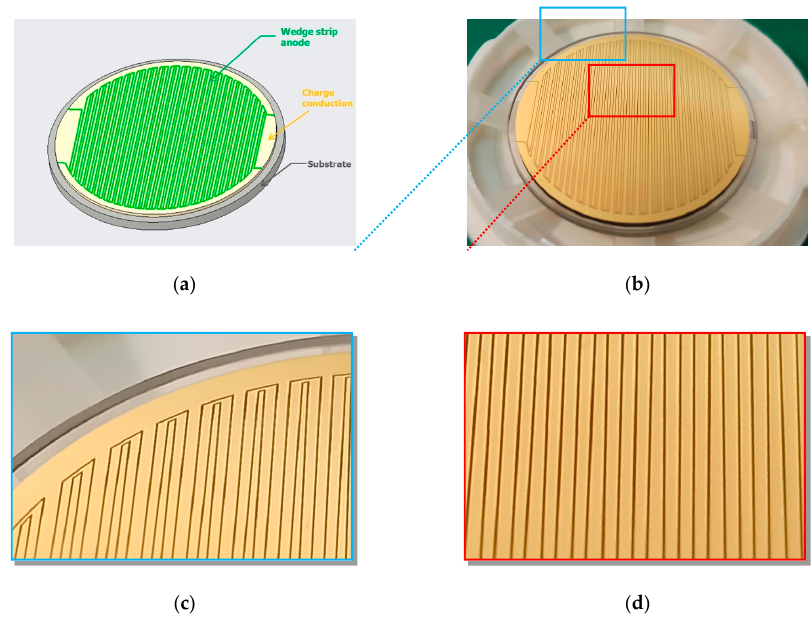
Figure 3. A pattern of a wedge strip anode for induced charge. ( a ) Model of a wedge strip anode. ( b ) Photograph of a wedge strip anode; ( c ) Zoomed details from the blue dotted box at the top left of ( b ). ( d ) Zoomed details from the red dotted box in the central area of ( b ).